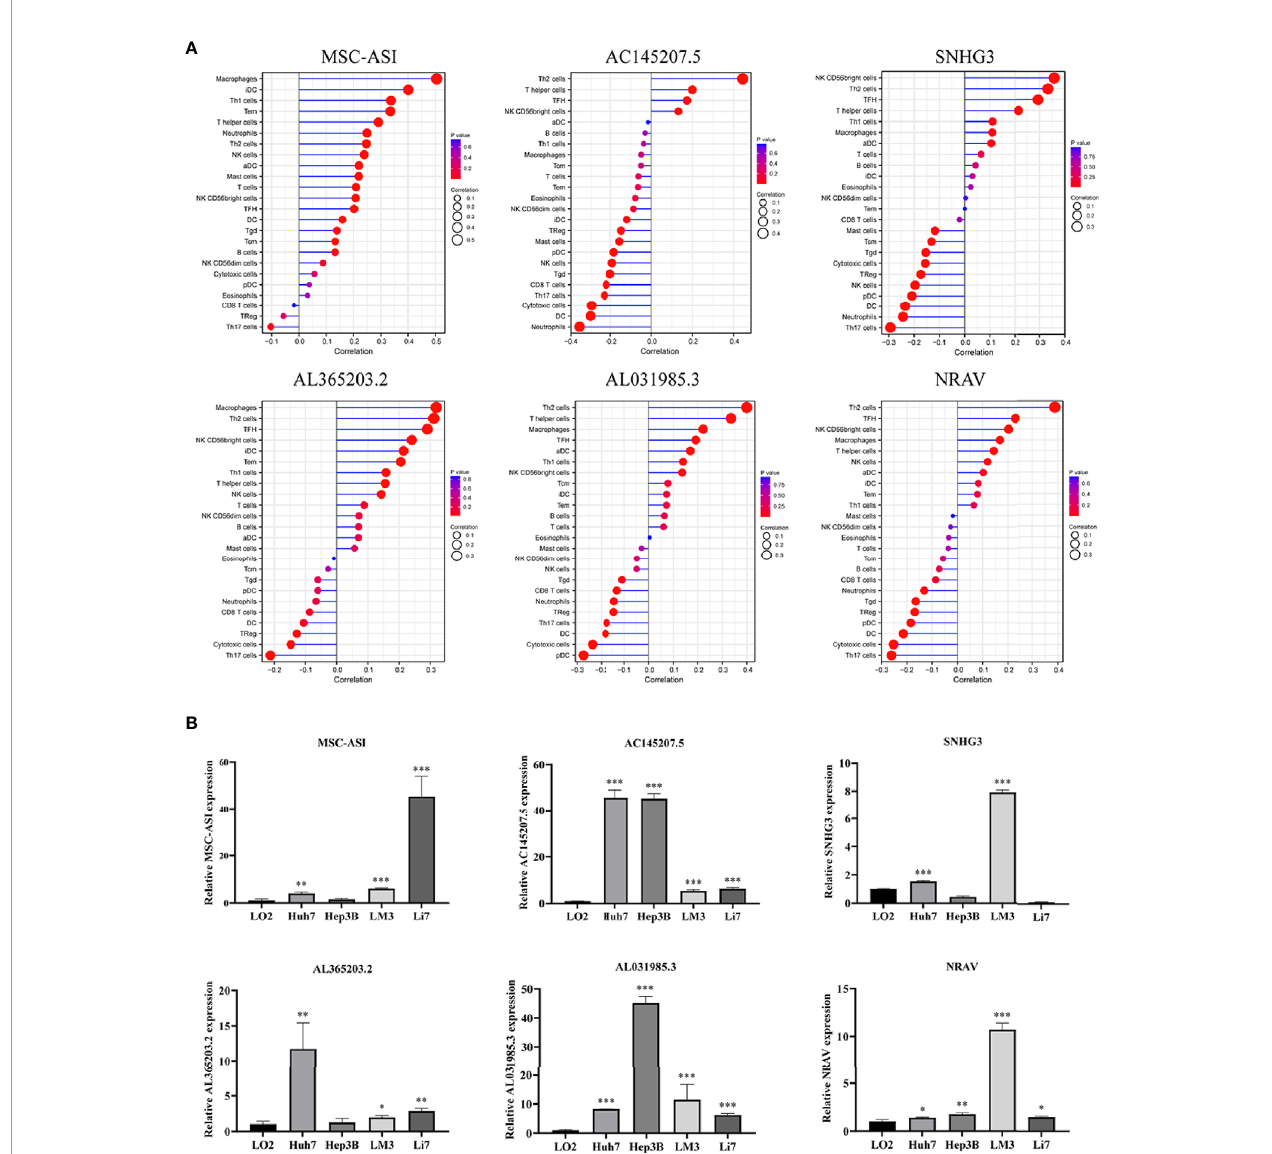
FIGURE 8 | ssGSEA analysis of six immune-related lncRNAs and Expression level of six immune-related lncRNAs in cell lines. (A) Correlation between 24 immune cells and six immune-related lncRNAs. (B) The expression of the six immune-related lncRNAs in four HCC cell line and one normal human hepatic cell line. *p < 0.05, **p < 0.01, ***p <